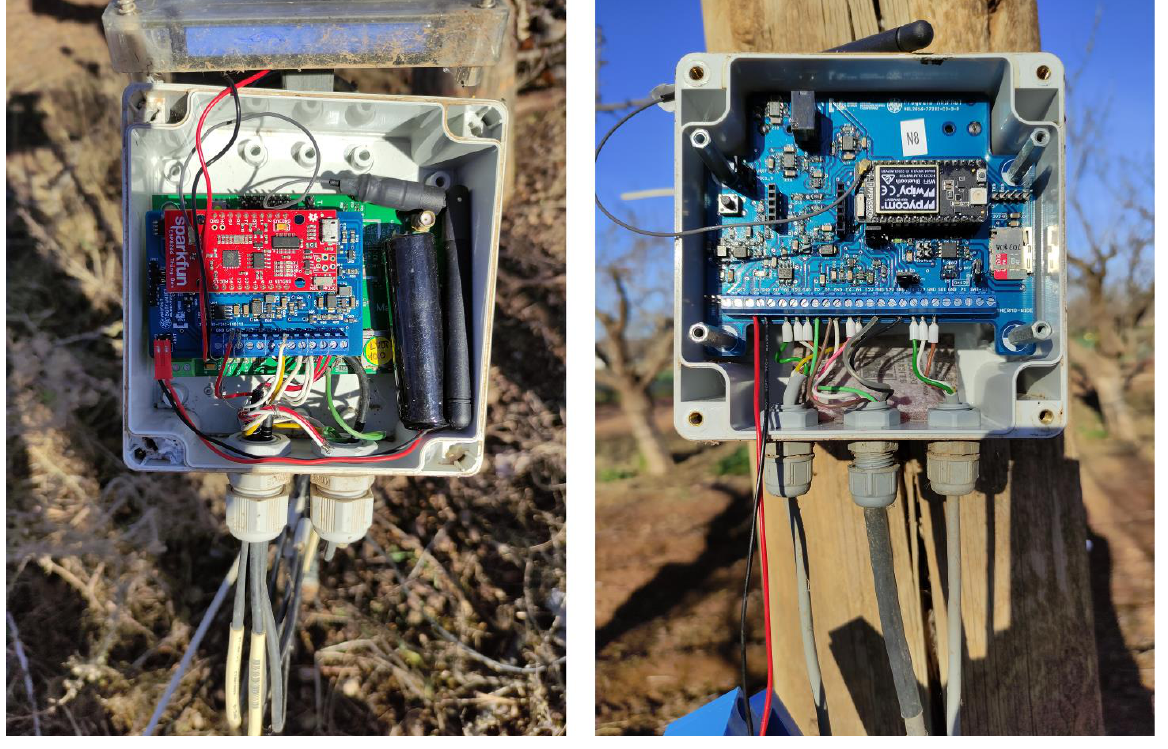
Figure 2. Pictures of type-A (left) and type-B (right) nodes. Table 2. Description of the deployed